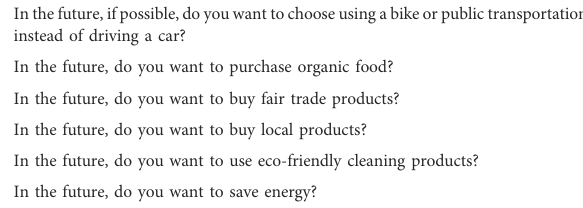
TABLE 1 The questions from the post-questionnaire regarding participants ’ intent to change